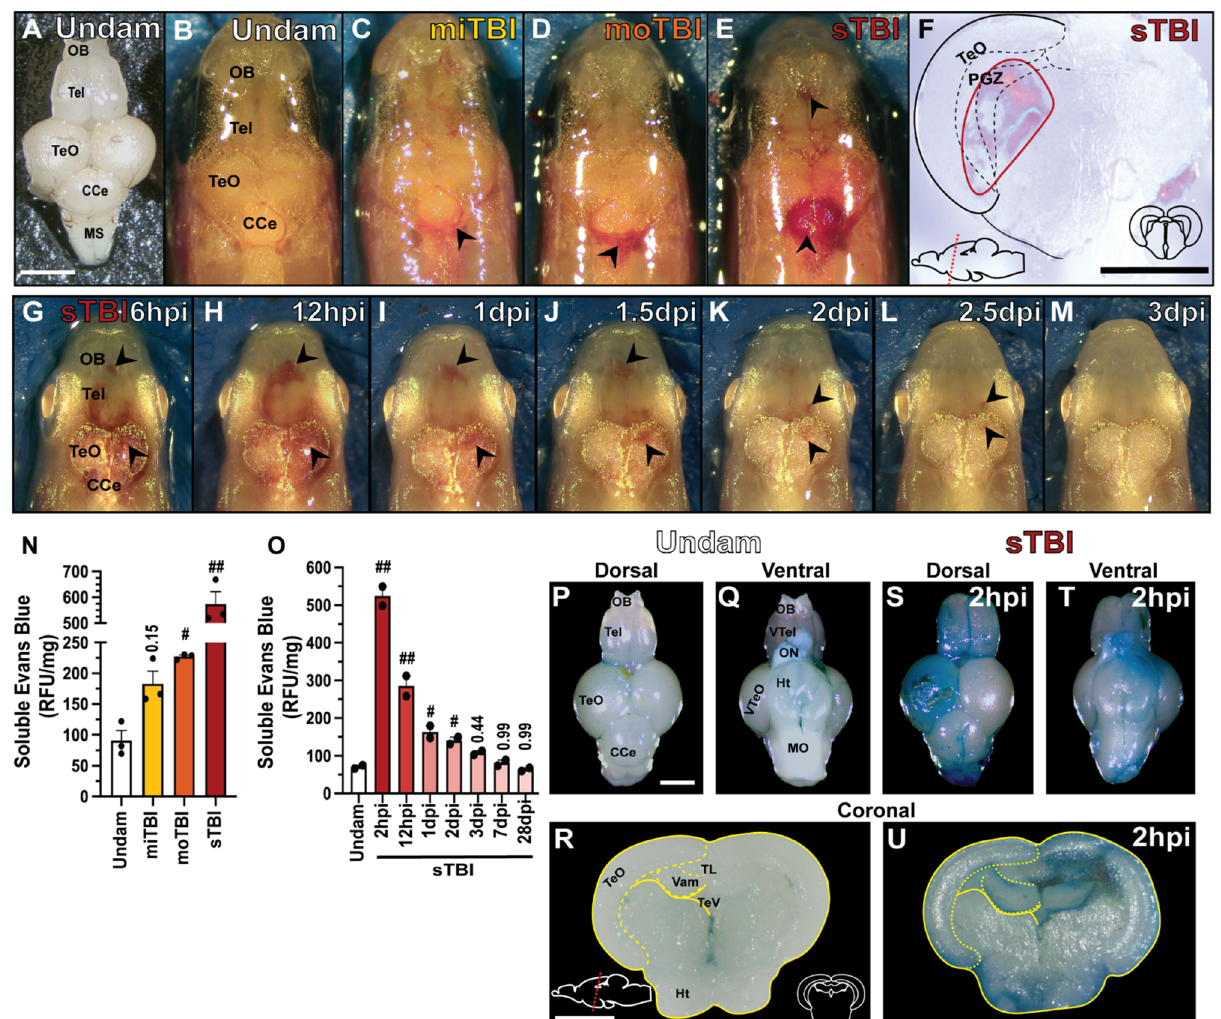
524.01 RFU/mg, p < 0.01, 12 hpi: 285.06 RFU/mg, p < 0.01, 1 dpi: 163.49 RFU/mg, p < 0.05, 2 dpi: 140.72 RFU/mg, p < 0.05, Figure 2O). Extracted dye levels returned to near undam- aged levels by 3 dpi and remained there through 28 dpi (undam: 70.73 RFU/mg, 3 dpi: 108.02 RFU/mg, p = 0.44, 7 dpi: 81.79 RFU/mg, p = 0.99, 28 dpi: 63.94 RFU/mg, p = 0.99, Figure 2O). The observed hematoma growth and BBB disruption led us to investigate edema and neuroinflammation.